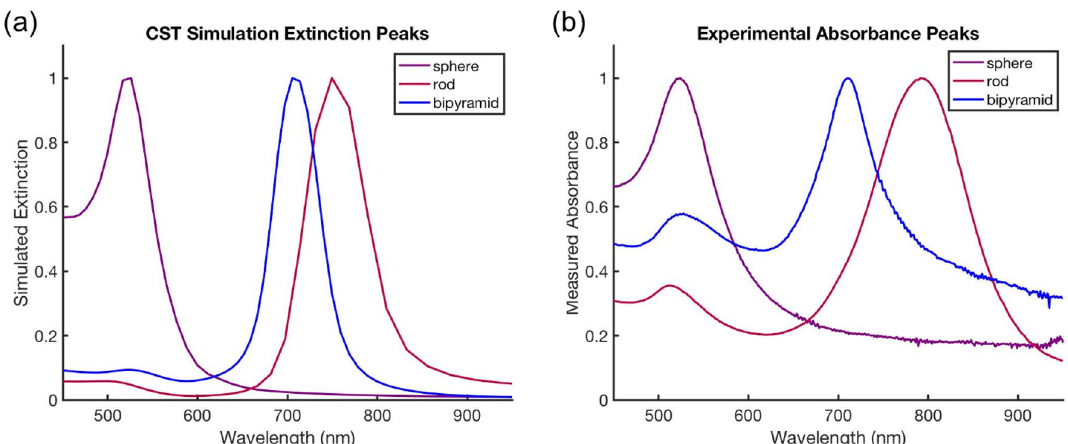
Figure 4. Comparison of simulated and experimental resonance spectra. Extinction peaks calculated from ( a ) simulation demonstrate good agreement with ( b ) experimentally captured spectra. The resonance wavelengths and shapes of peaks are very